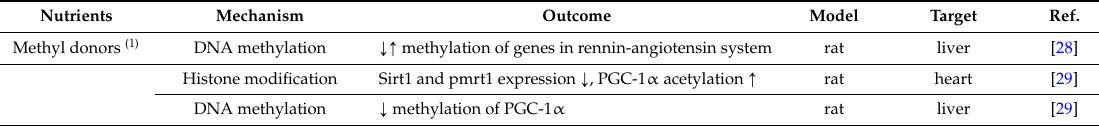
Table 1. Effect of maternal nutritional exposure in utero on epigenetic modifications in animal studies.